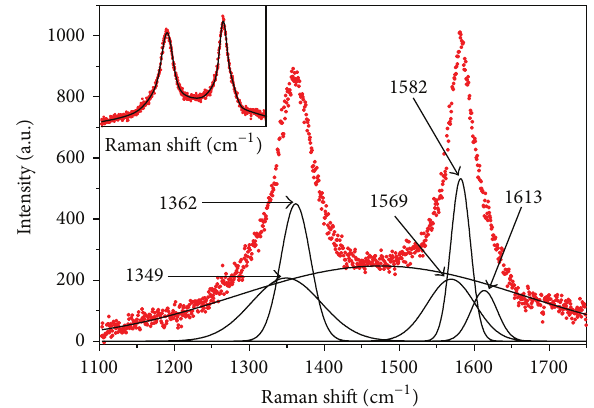
Figure14:RamanspectrumrecordedforNi/ n -SiCcontactannealed at 1050 ∘